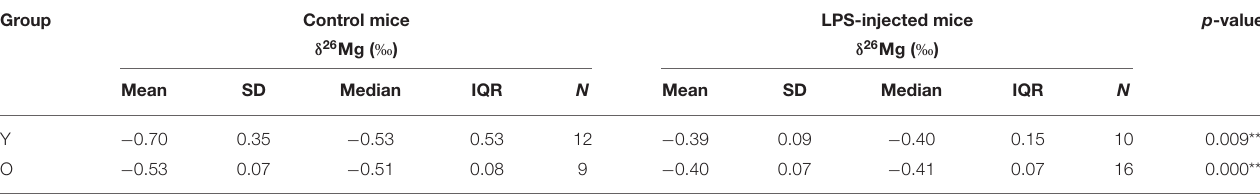
TABLE 1 | Mg isotopic composition of blood plasma for young (Y) and aged (O) LPS-injected mice and matched controls. Group Control